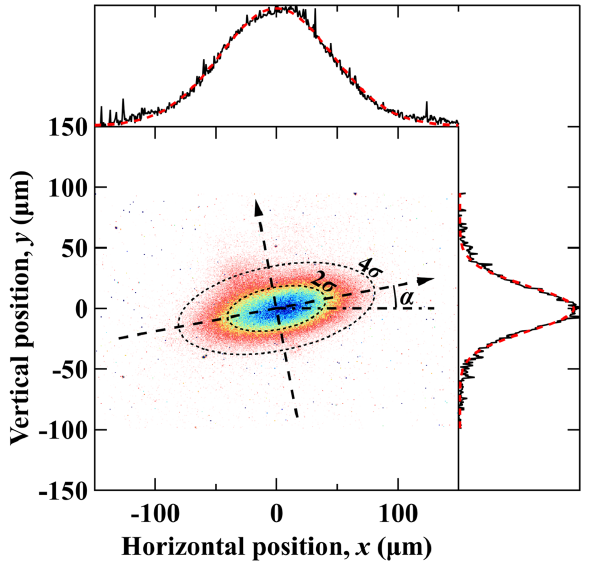
shown as solid lines in the top and right panels in Fig. 2, (dashed curves in the top and right panels in Fig. 2) to the integrated profiles is the projected image size Σ which can be used to extract the projected source size Σ using Eq. (1) as well. source ;x;y